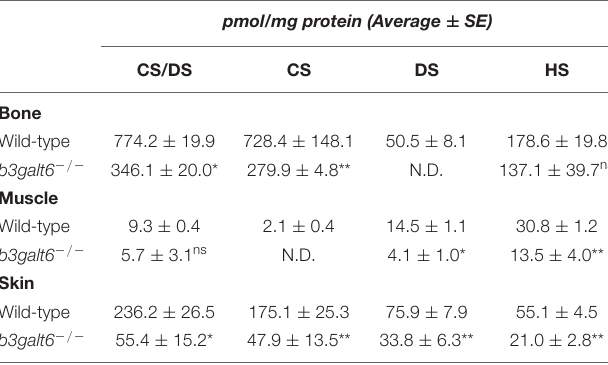
TABLE 1 | Concentrations of GAG disaccharides in wild-type and b3galt6 − / − zebrafish